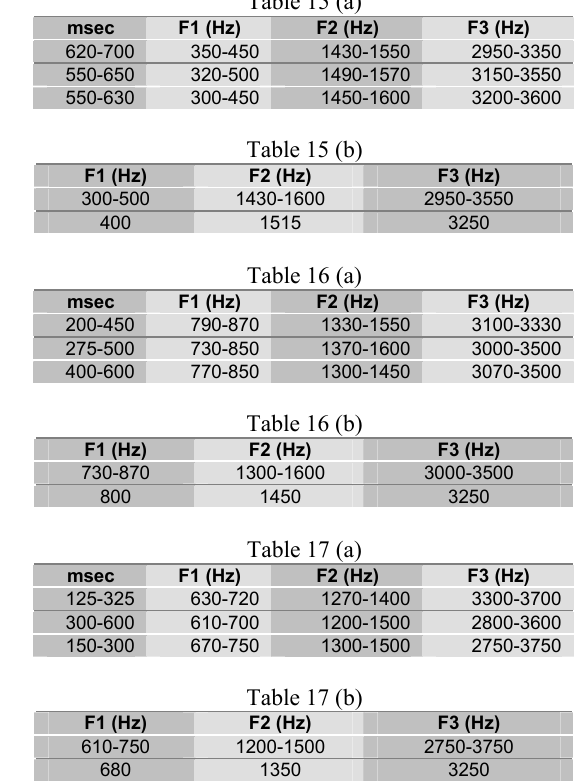
Fig 1: Spectrogram, LPC, and formant track for utterance “sar ə ”, MAK